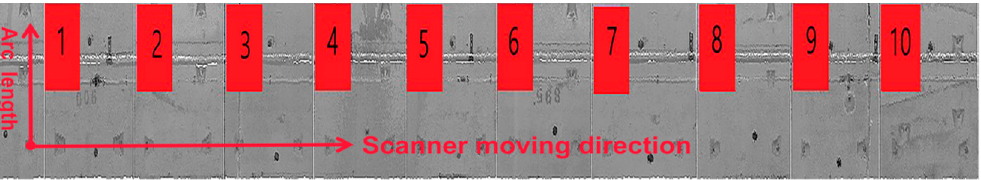
Figure 6. Recognition results of longitudinal ring